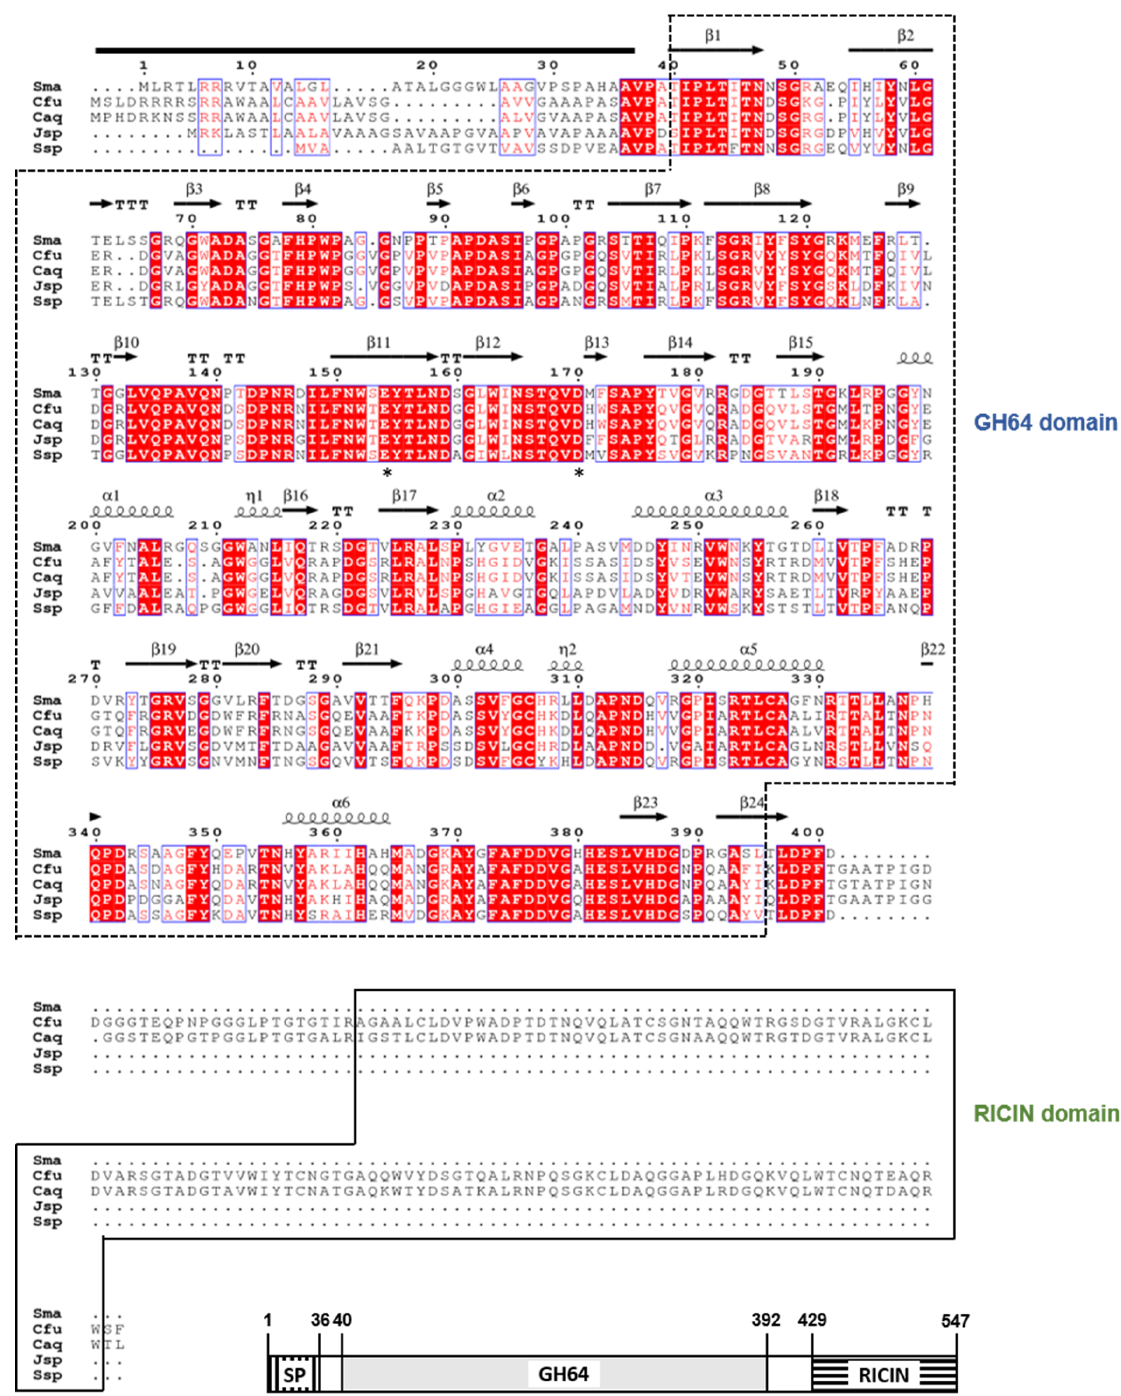
Figure 1. Domain architecture of Cellulosimicrobium funkei HY-13 GH64 endo- β -1,3-glucanase and structure-based sequence alignment of the enzyme and its structural homologs. The first line displays the secondary structure elements ( α -helix, squiggle; β -strand, arrow; 3 10 -helix, η ; β -turn, TT) of Streptomyces matensis DIC-108 endo- β -1,3-glucanase (PDB code: 3GD0) employed as a template. Sequences (GenBank accession numbers): Sma, Streptomyces matensis DIC-108 endo- β -1,3-glucanase (BAA34349); Cfu, C. funkei HY-13 endo- β -1,3-glucanase (MT332201); Caq, Cellulosimicrobium aquatile endo- β -1,3-glucanase (WP_083711238); Jsp, Jiangella sp. sugar hydrolase (WP_092617602); and Ssp, Streptomyces sp. sugar hydrolase